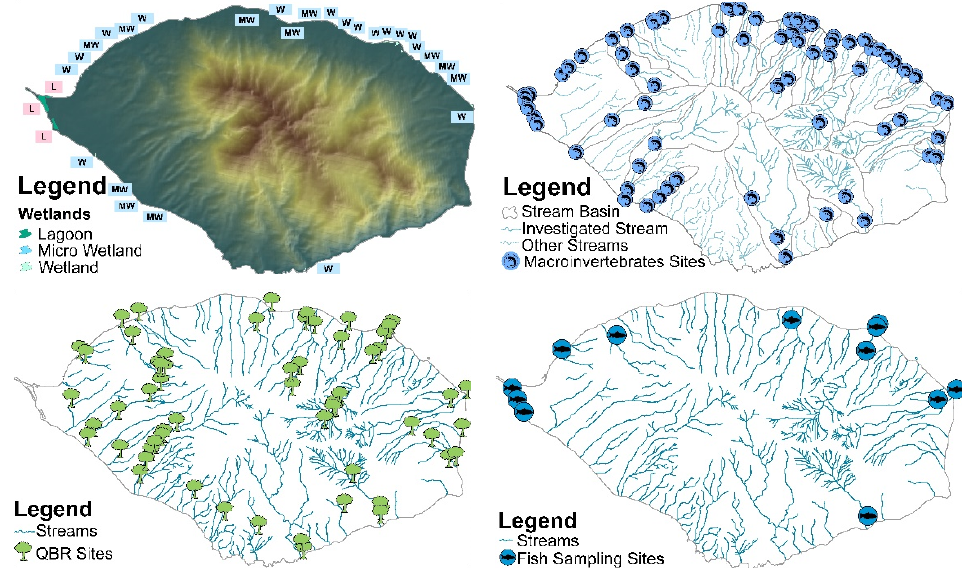
Figure 10. Example of biodiversity inventory results from ongoing work at Samothraki: coastal wet- land inventory ( up left ), freshwater benthic macroinvertebrate sampling sites and condition assess- ment ( up right ), riparian vegetation and condition assessment ( bottom left ), freshwater fish sam- pling sites ( bottom right ).